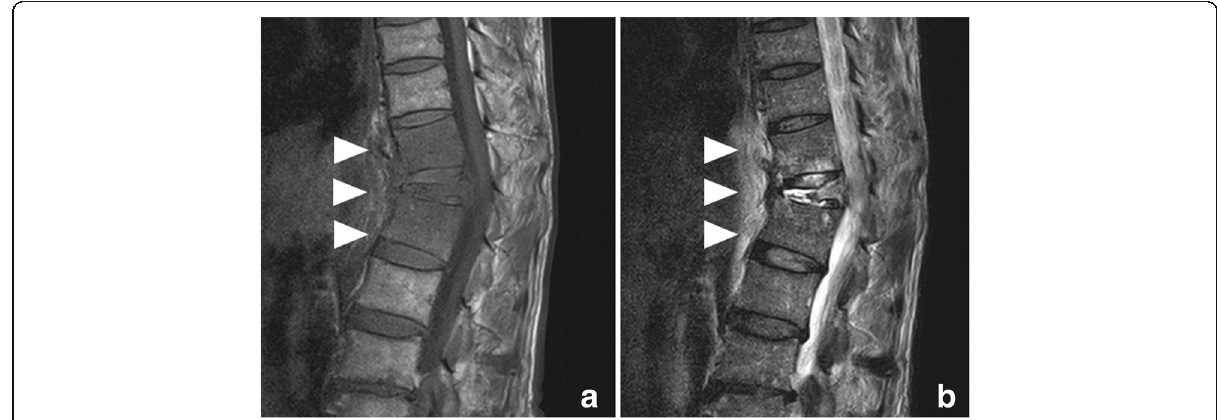
Fig. 3 Postoperative lumbar MRI. a , b MRI revealed low T1-weighted signals and high T2-weighted signals in the 12th thoracic vertebral body, and the signals spread to the upper and lower intervertebral disk space (white